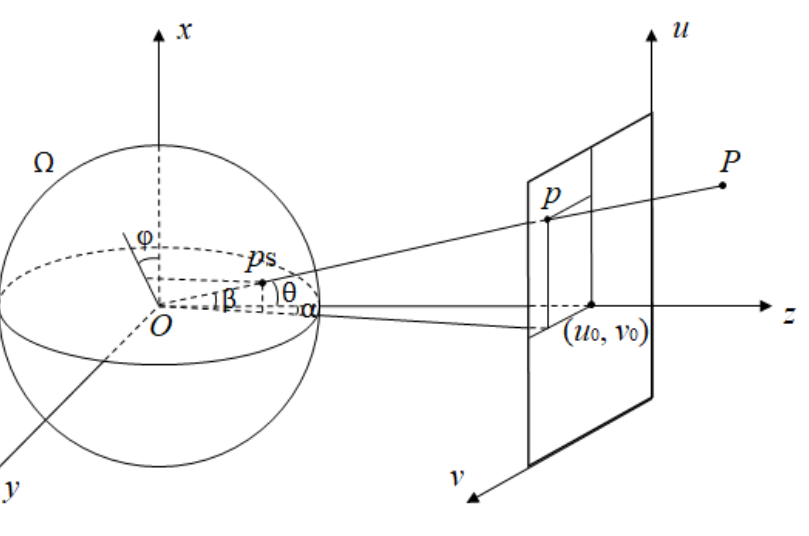
Figure 2. Spherical imaging